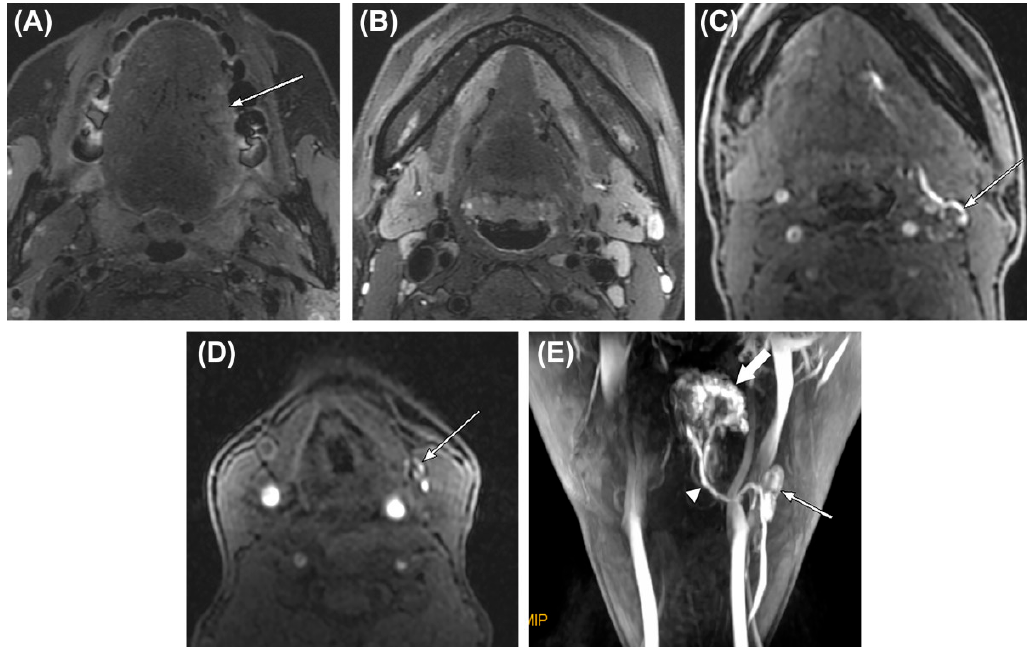
Figure 3. A 38-year-old woman with oral tongue cancer and palpably negative neck. ( A , B ) Fat-saturated T2-weighted MRI scans show a shallow infiltrative tumor on the left lateral surface of oral tongue (arrow) and several small lymph nodes in the submandibular areas. ( C , D ) After peritumoral injection of contrast, MR lymphography revealed two first-enhanced lymph nodes in left level IB and IIA (arrows) on the first phase of the dynamic scan, respectively. ( E ) The maximum intensity projection reconstruction image of MR lymphography shows the contrast injection site in the tongue (thick arrow), the assumed sentinel lymph node (thin arrow), and the lymph vessel connecting them (arrowhead). After neck dissection, the assumed sentinel lymph nodes observed on MR lymphography revealed no metastasis on histologic examination [22]. Figure used with permission of John Wiley and Sons©, permission license number 4807630108259.